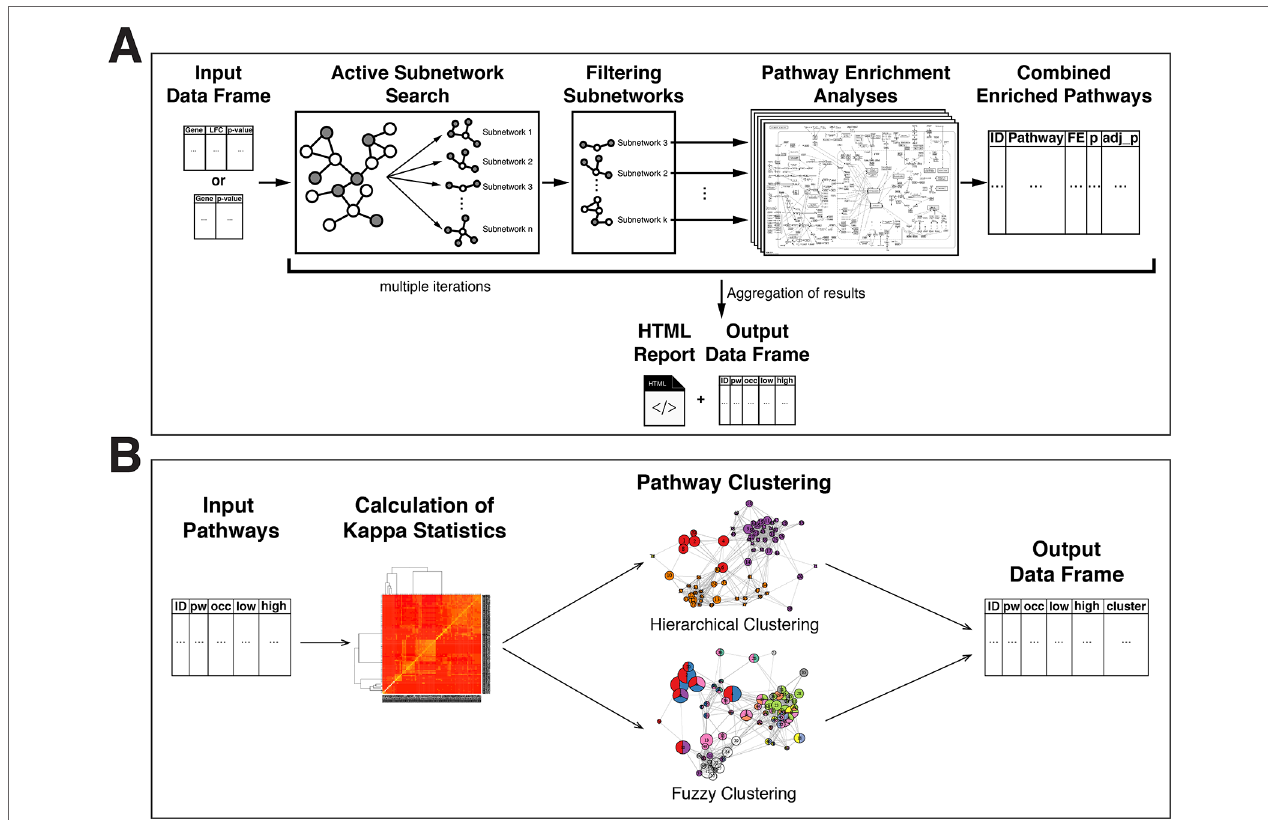
FIGURE 1 | Flow diagrams of the pathfindR methods. (A) Flow diagram of the pathfindR active-subnetwork-oriented pathway enrichment analysis approach. (B) Flow diagram of the pathfindR pathway clustering